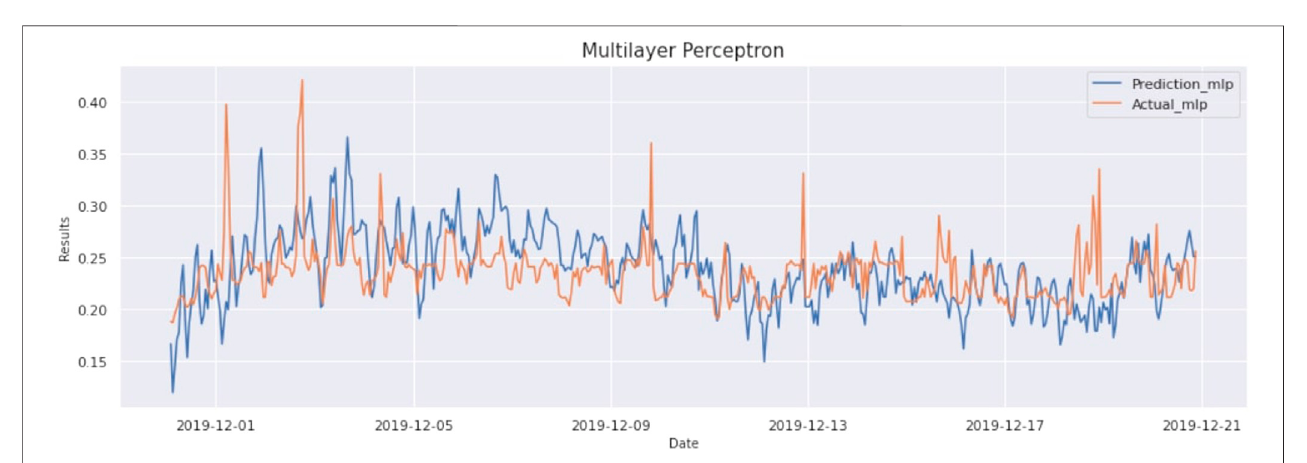
FIGURE 6 | Prediction vs Actual result of Multilayer Perceptron (Ontario Demand